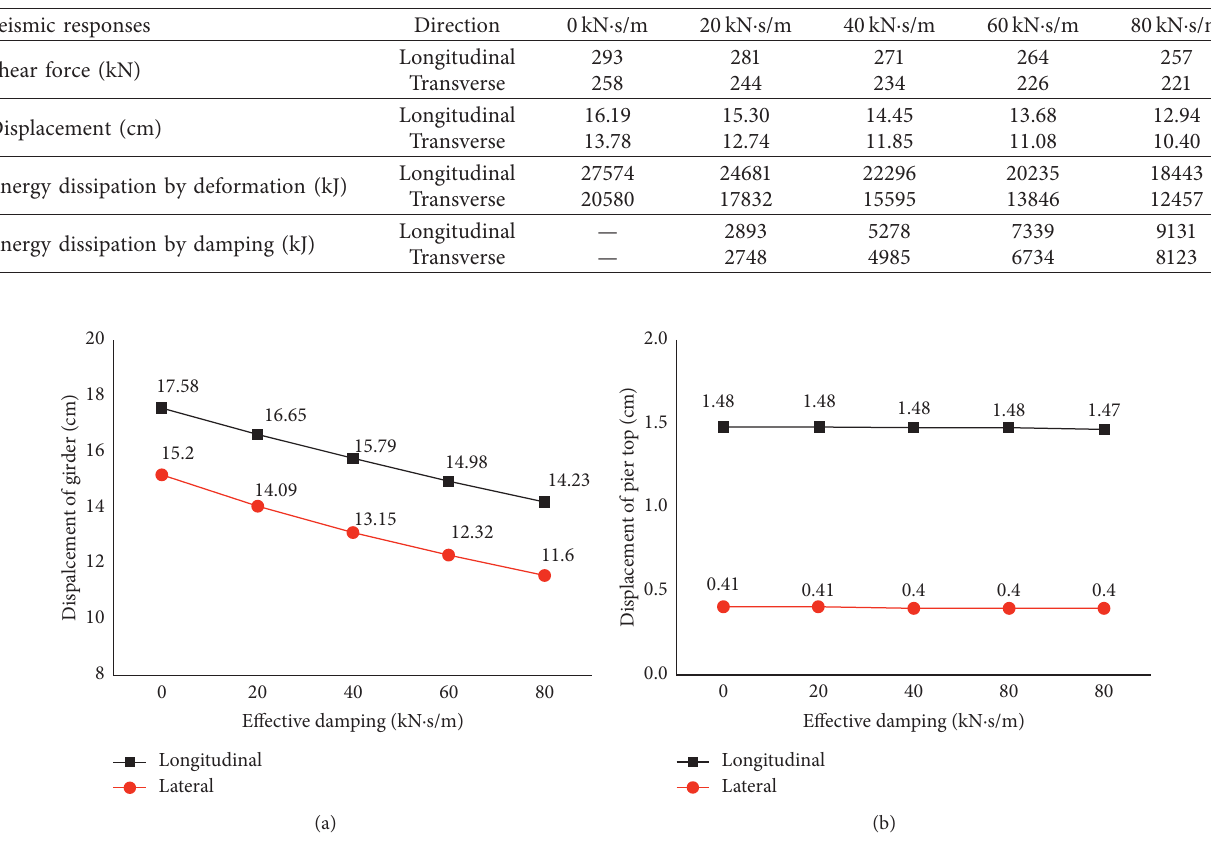
Figure 7: Displacement of bridge in different directions with the variation of effective damping: (a) displacement of girder; (b) displacement of pier